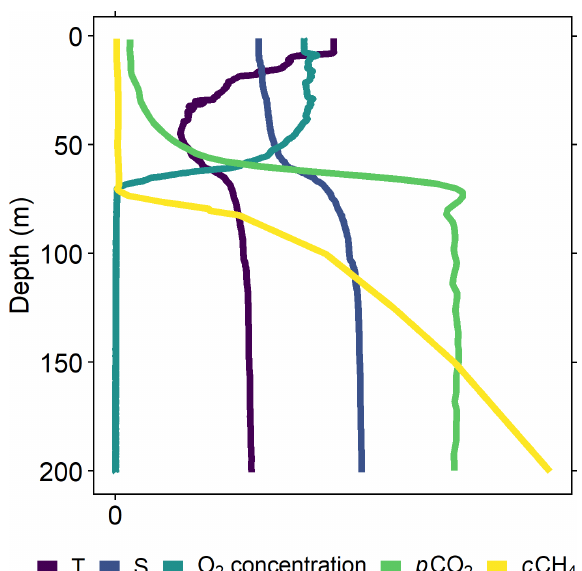
Figure 2. Vertical profiles of parameters relevant for this study from 58.58 ◦ N, 18.23 ◦ E, on 23 May 2019, which show shapes typical for the summer situation in the central Baltic Sea. The profiles display temperature, salinity, oxygen concentration, CO 2 partial pressure, and CH 4 concentration on an arbitrary scale, truncated at a depth of